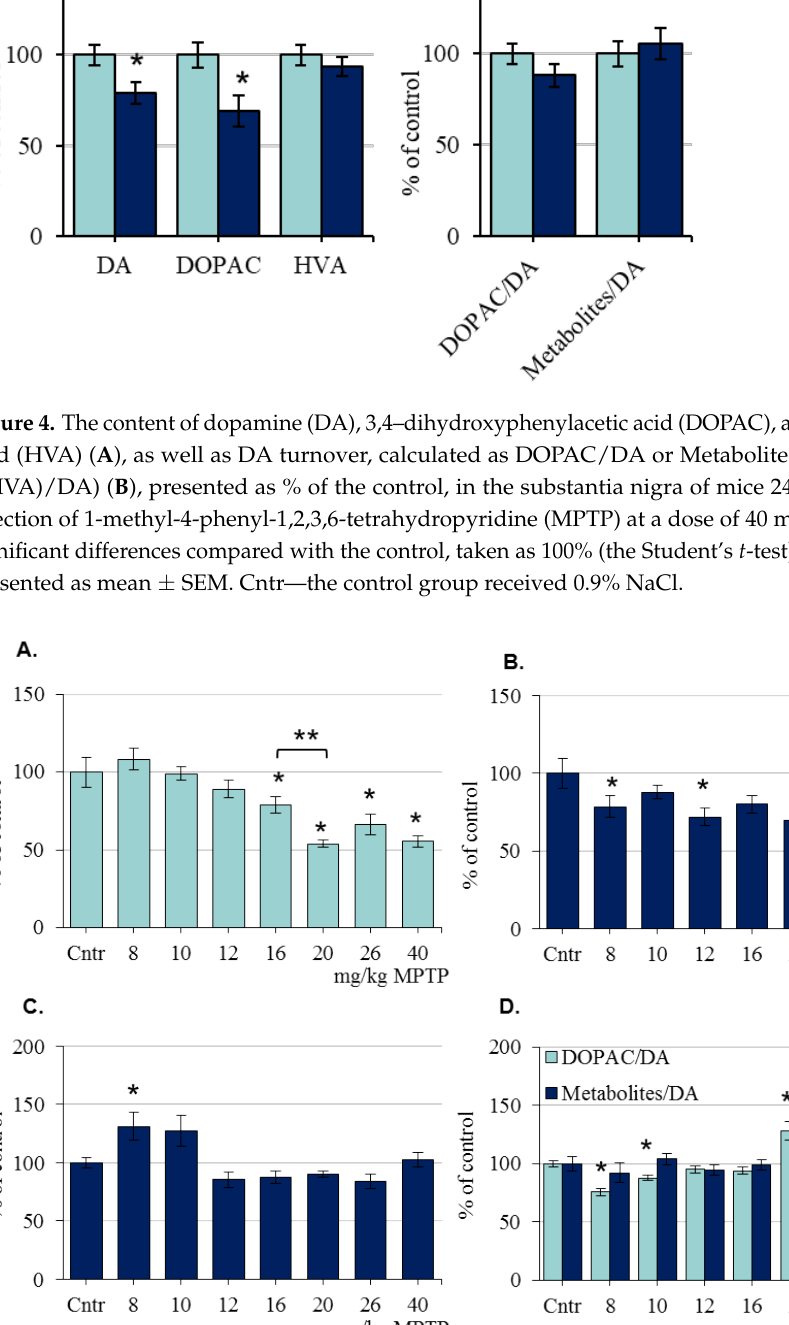
Figure 5. The content of dopamine ( A ), 3,4-dihydroxyphenylacetic acid (DOPAC) ( B ), and homovanillic acid (HVA) ( C ), as well as dopamine turnover, calculated as DOPAC/DA or Metabolites/DA ((DOPAC + HVA)/DA) ( D ), presented as % of the control, in the substantia nigra of mice 24 h after each of the successive injections of 1-methyl-4-phenyl-1,2,3,6-tetrahydropyridine (MPTP) at increasing doses from 8 to 40 mg/kg (“n” per group = 6–8). * p < 0.05, significant differences compared with the control, taken as 100% (the Student’s t -test). ** p < 0.05, significant differences between the selected parameters (one-way ANOVA). Data are presented as mean ± SEM. Cntr—the control group received 0.9% NaCl.